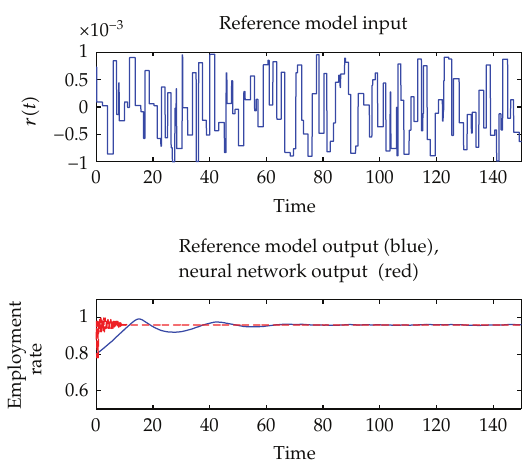
Figure 6: MRC of GGC model with a reference